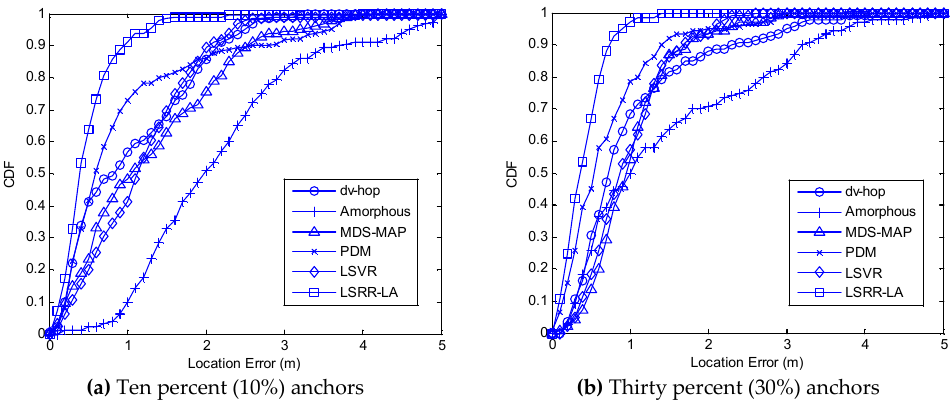
Figure 13. Comparison of the cumulative distribution function (CDF).